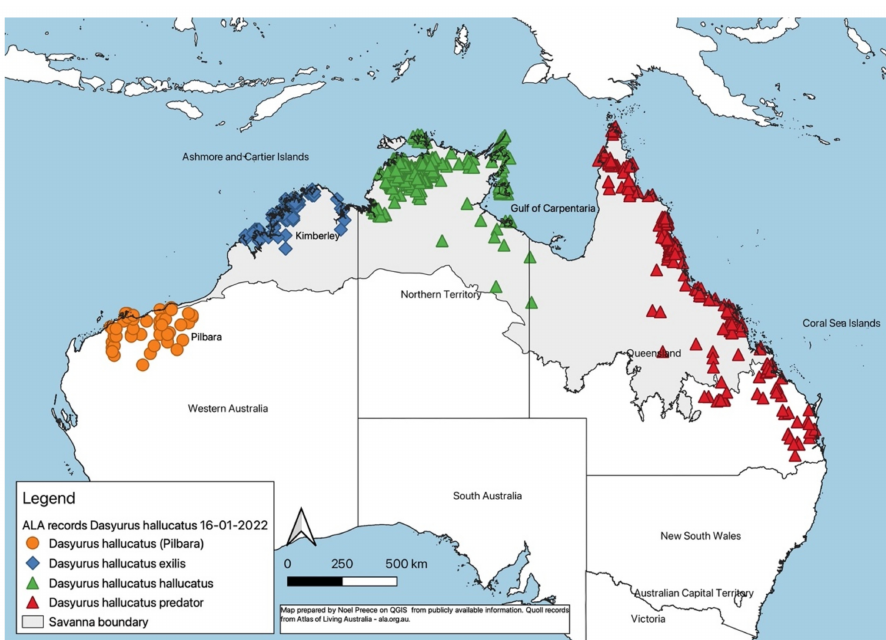
Figure 1. Records of northern quolls Dasyurus hallucatus from the Atlas of Living Australia (ALA) (https://www.ala.org.au/ (accessed on 16 January 2022)). Note the large gaps in distribution across the southern Gulf of Carpentaria and the northern and western distributions, and the minor gap between the Northern Territory ( D. h. hallucatus ) and Western Australian ( D. h. exilis )